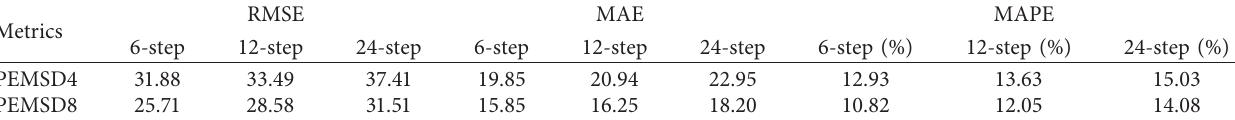
Table 3: Performance comparison of different baseline models predicting future data at 12 time steps on PEMSD8 dataset. RMSE MAE MAPE Metrics